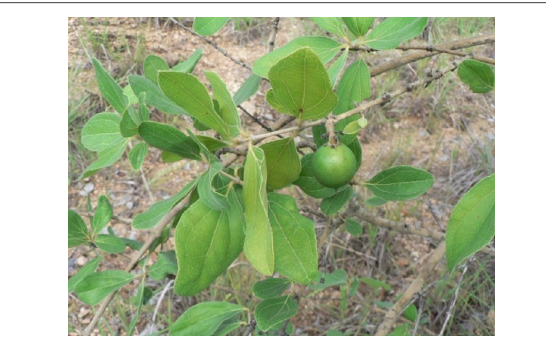
Fig. 8 Structure of Umbelliferone (1)